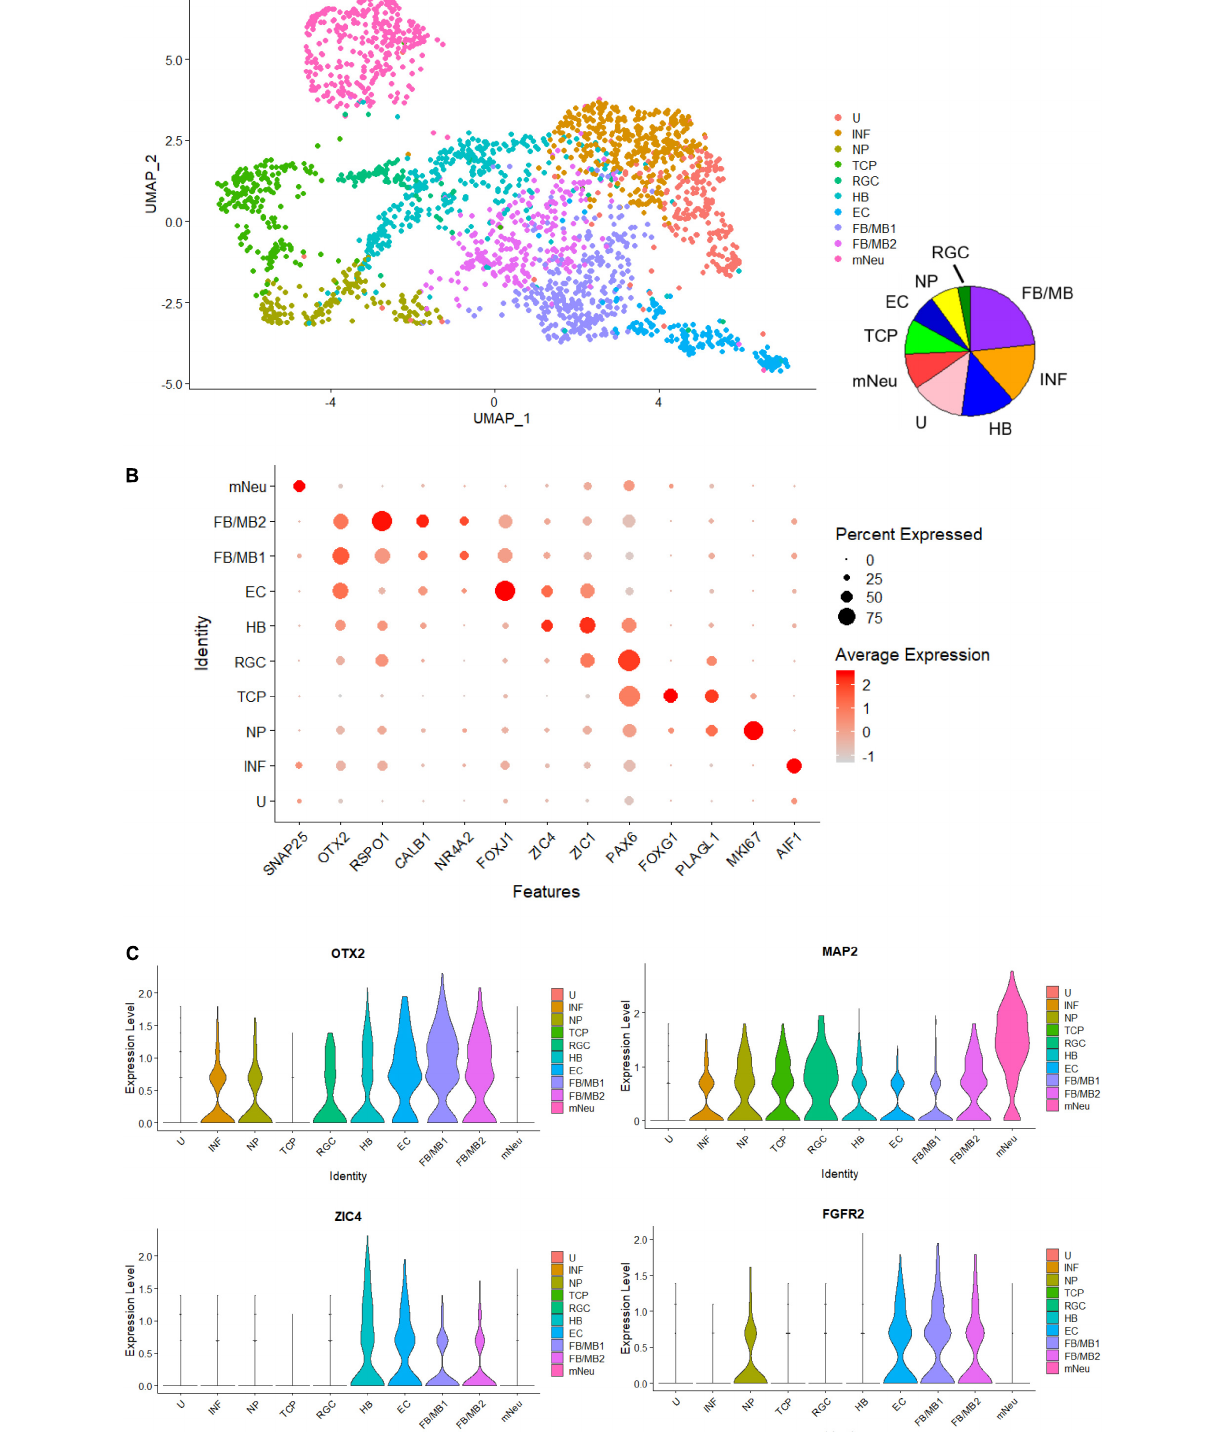
Frontiers in Neuroscience |